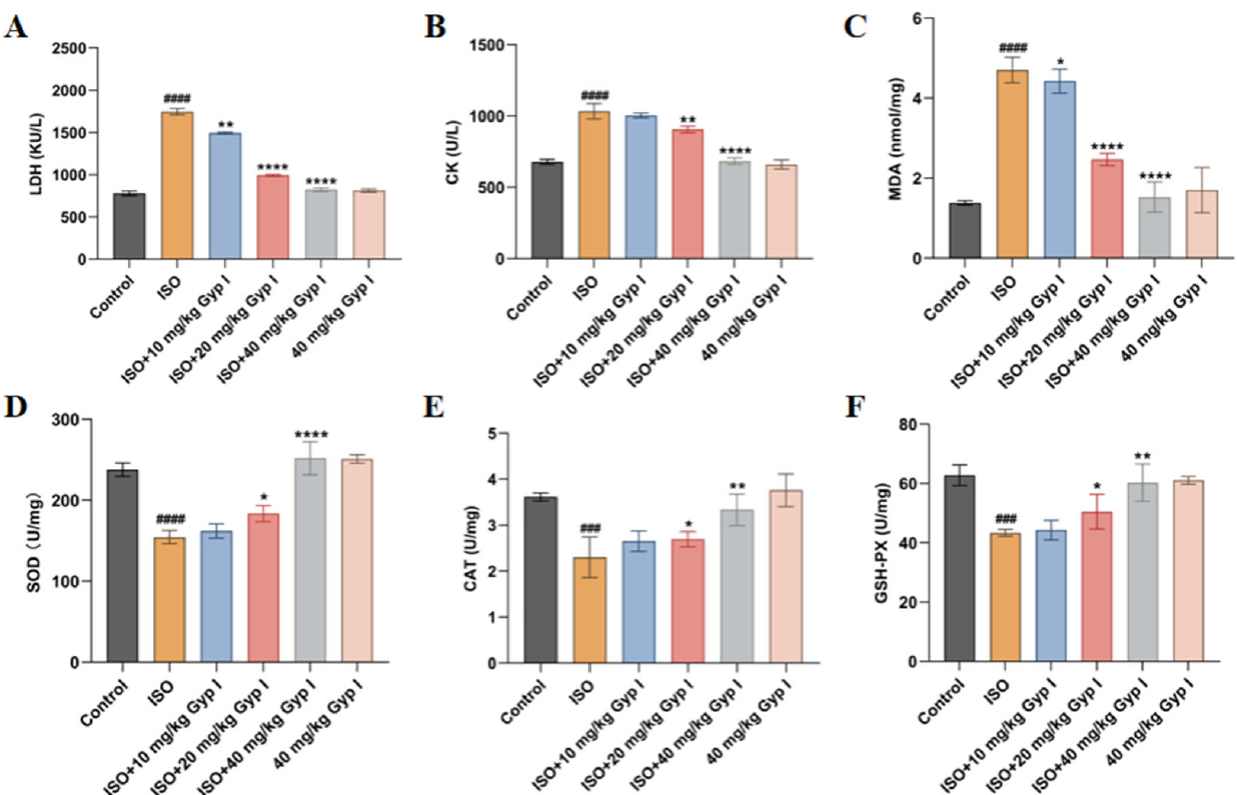
Figure 7. Biochemical assessment in serum and tissues of mice in each group: ( A ) LDH levels in serum. ( B ) CK levels in serum. ( C ) MDA levels in tissues. ( D ) SOD levels in tissues. ( E ) CAT levels in tissues. ( F ) GSH-PX levels in tissues ( n = 5, mean ± SD, ###: p < 0.001, ####: p < 0.0001 compared with Control group; *: p < 0.05, **: p < 0.01, ****: p < 0.0001 compared with ISO group).